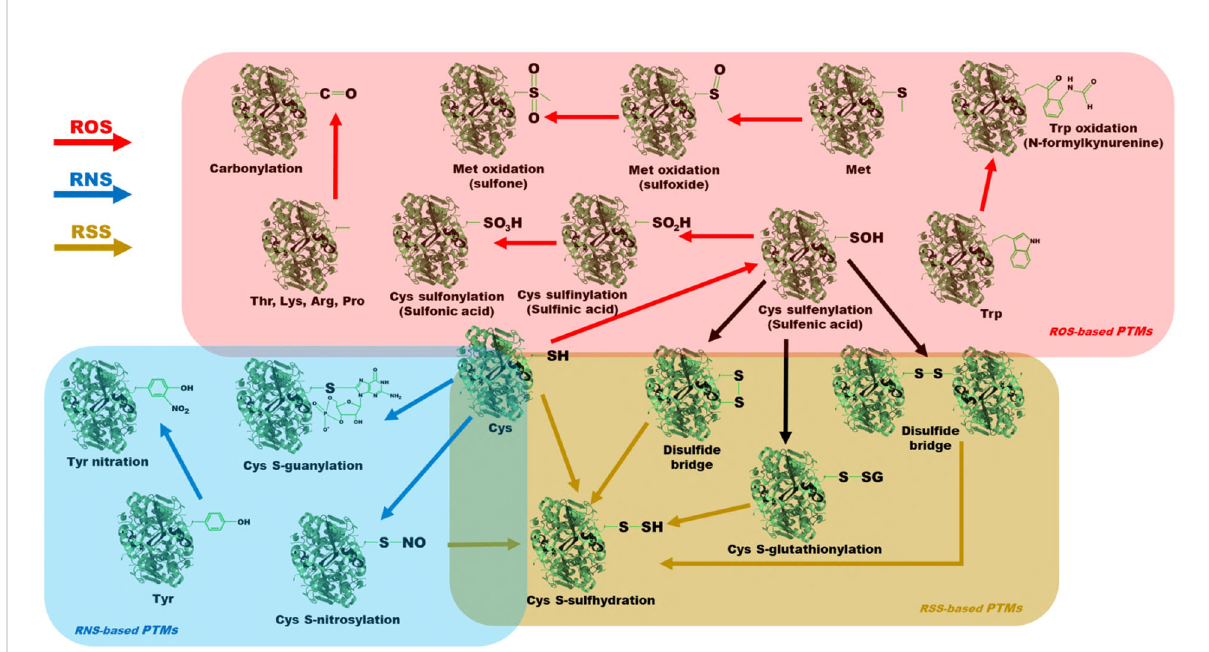
FIGURE 2 Schematic representation of the different redox-based PTMs of the different protein residues. In red, we fi nd the different ROS-based PTMs: cysteine oxidation, methionine oxidation, tryptophan oxidation and carbonylation. In blue, the different RNS-based PTMs are shown: cysteine S- nitrosylation, cysteine S-guanylation and tyrosine nitration. In gold, the different RSS-based PTMs are indicated: cysteine